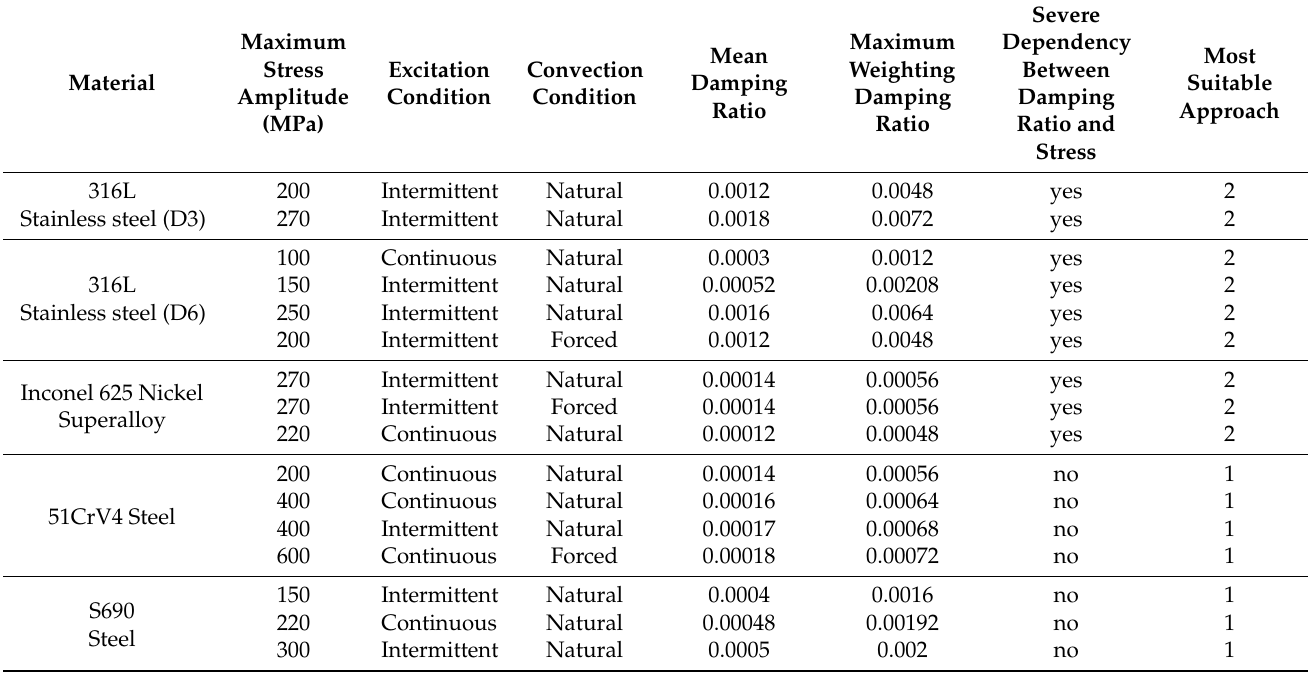
Table 5. Summary of the analyzed results for several materials and the approach which presented better correlation with the experimental